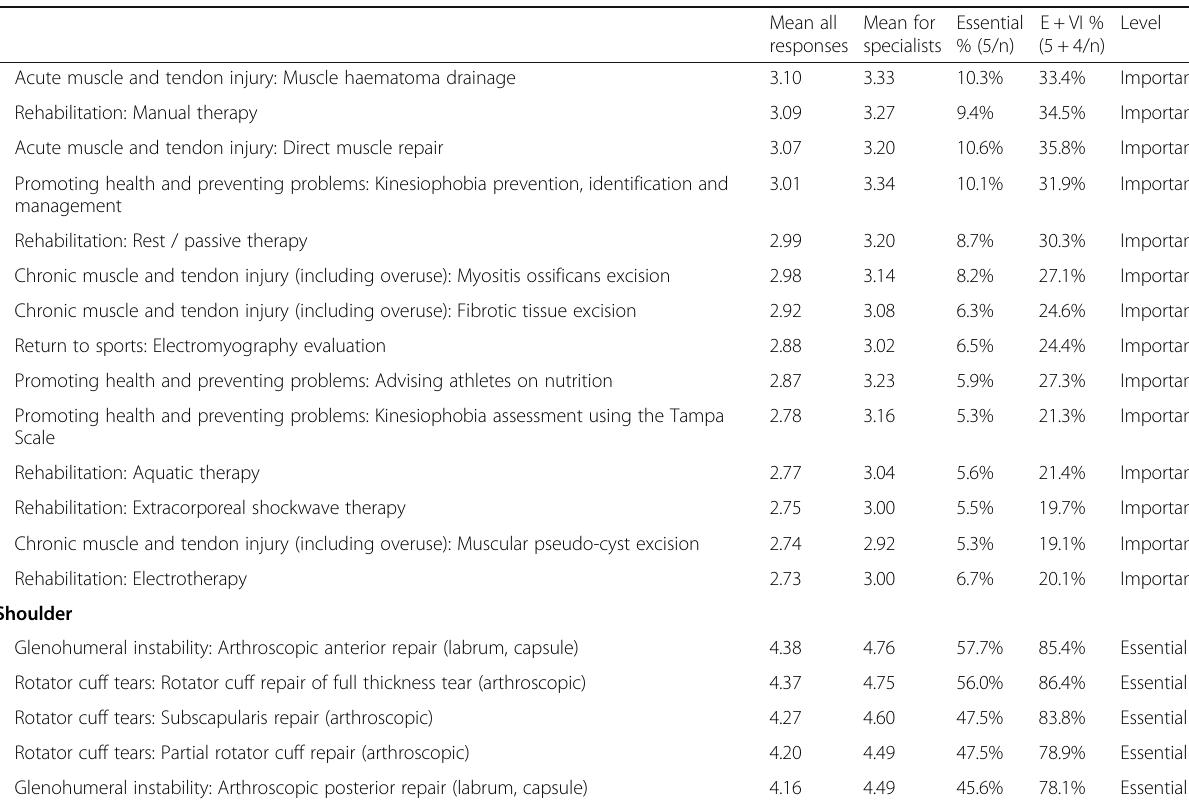
Table 2 For insertion in the results section as indicated above